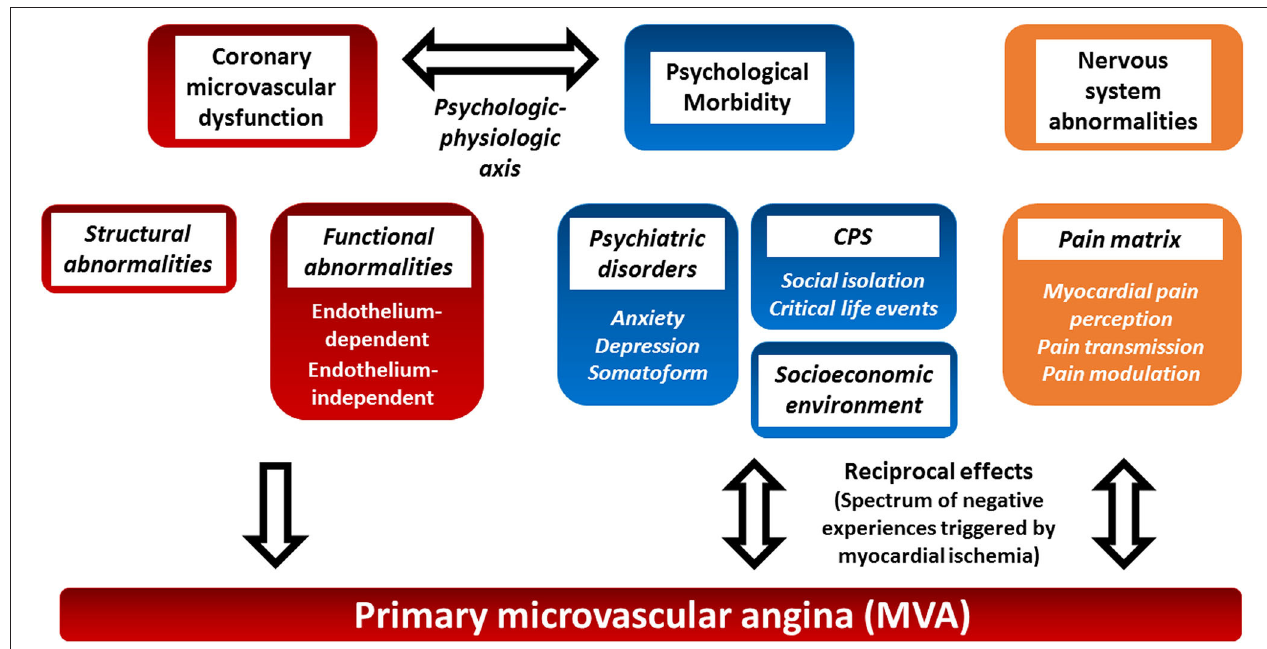
FIGURE 1 | Proposed pathophysiology of primary microvascular angina and potential role of psychosocial factors and the central nervous system. Primary microvascular angina (MVA), formerly known as coronary syndrome X, is defined as the clinical manifestation of myocardial ischemia caused by coronary microvascular dysfunction (CMD) in the absence of obstructive CAD, epicardial vasospasm, and structural heart disease. Structural and functional coronary microcirculation alteration results in CMD. The clinical manifestation of MVA, psychosocial factors, and the central nervous system autonomic/afferent pathways may have reciprocal multifaceted activities (see text for details). CMD, coronary microvascular dysfunction; CPS, chronic psychosocial stress; MVA, primary microvascular